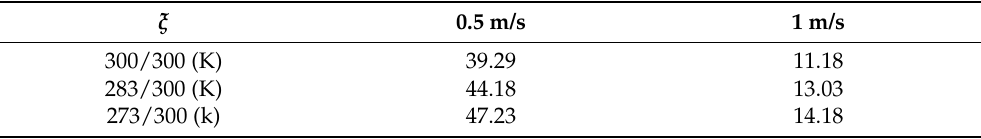
Table 1. Pressure loss coefficient in different